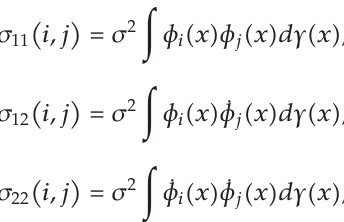
Figure 4: Example 5.1: (cid:2) a (cid:3) Crossing intensities μ s Sample size for simulated gamma processes γ i ; N (cid:7) 10 2 : dotted line; N (cid:7) 10 3 : dashed dotted line; N (cid:7) 10 4 : dashed line; Crossing intensity μ s (cid:2) u (cid:3) : solid line. (cid:2) b (cid:3) Corresponding relative errors μ s conditional moment generating